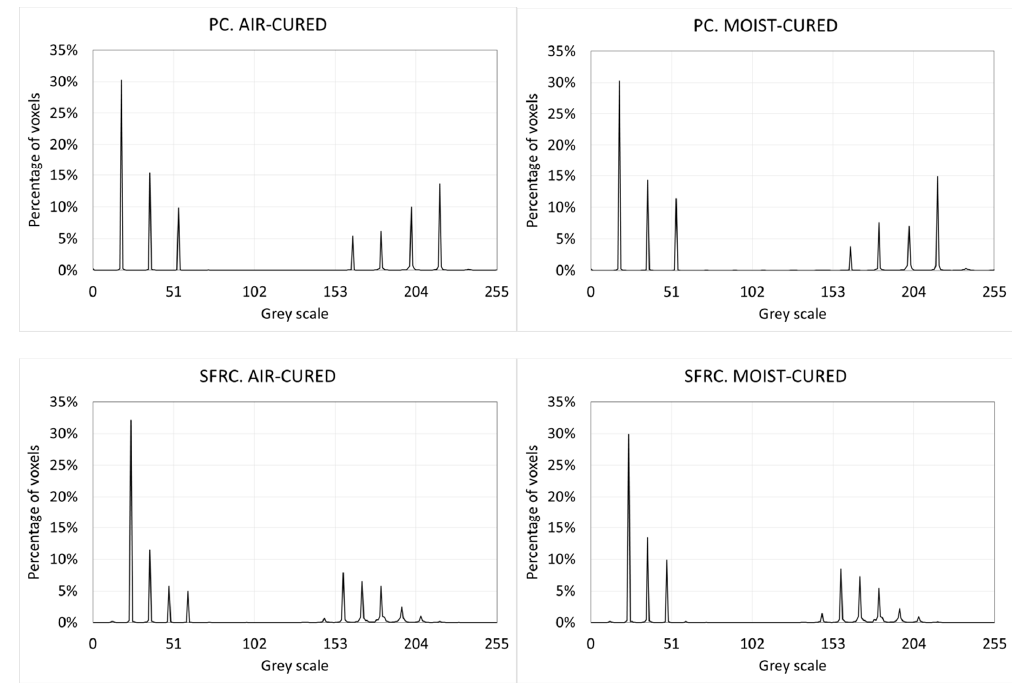
Figure 3. Histograms of gray scale.